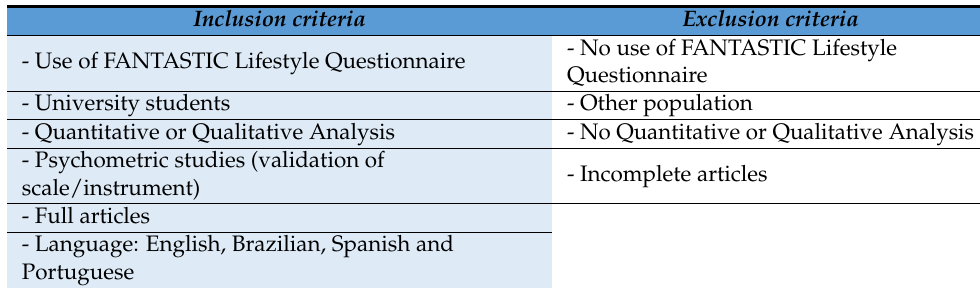
Table 1. Criteria for inclusion and exclusion from the